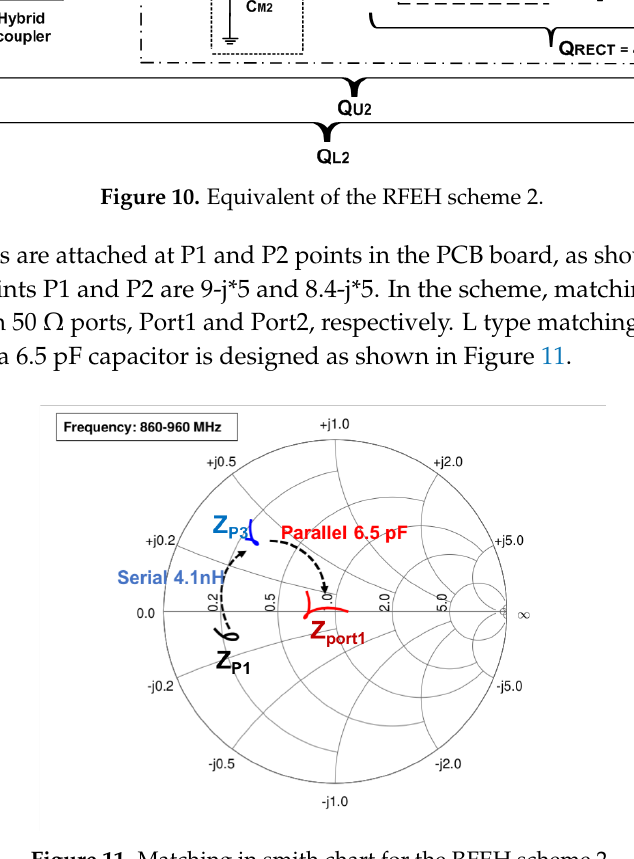
Figure 11. Matching in smith chart for the RFEH scheme